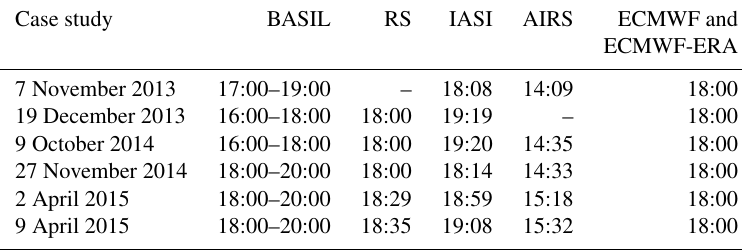
Table 2. Time intervals for all sensors/models for all case studies considered. Case